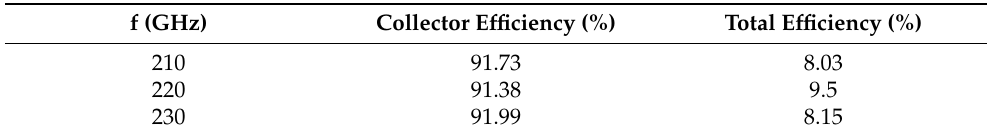
Figure 12. Electron distribution in the double stages depressed collector.